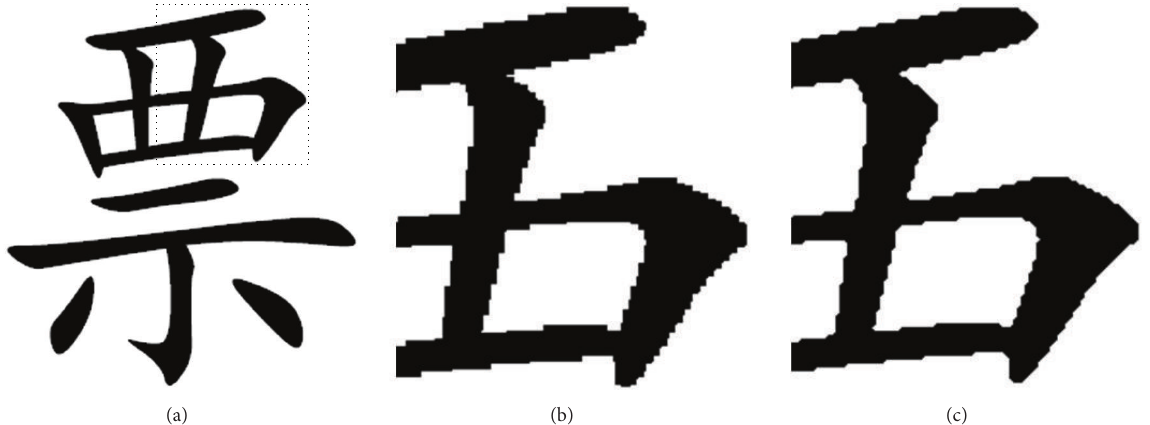
Figure 4: Comparison of traditional interpolation method and our method. Because the image resolution is too high after magnifying, we only showed the dotted line area of original image: (a) original image; (b) nearest-neighbor interpolation method; (c) our proposed scaling interpolation